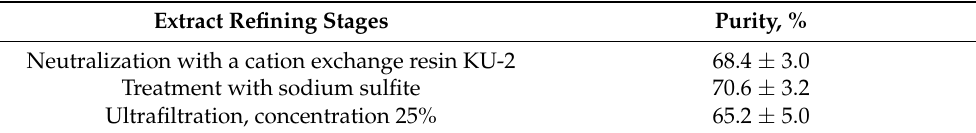
Table 6. Purification extract bark of Pinus sylvestris L. [106]. Extract Refining Stages